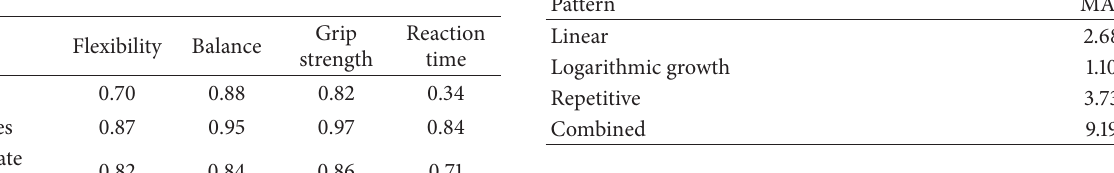
Table 3: Classification performance (average 𝐹1 of 4-fold cross- validation).